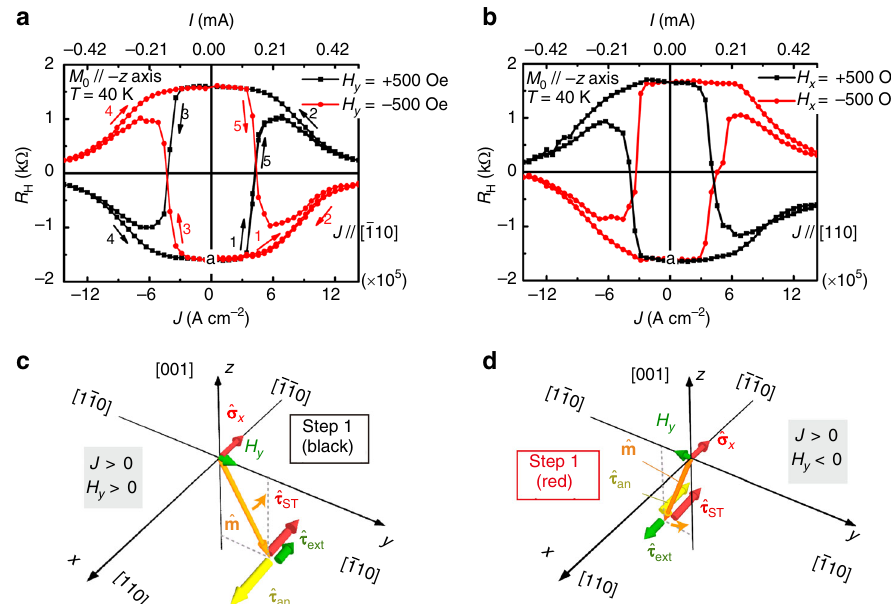
Fig. 2 SOT switching (40 K) and the relevant switching mechanism. a , b Field-assisted SOT switching with J // (cid:1) 1 10 ½ (cid:2) and H y = ± 500 Oe ( a ) and with J // [110] and H = ± 500 Oe ( b ). c , d Illustrations of the torques exerted by the external fi eld ( ^ τ x Þ with J > 0 when H y > 0 ( c ) and H y < 0 ( d ). ^ m is in the y-z plane. (Source data are provided as a Source Data fi along the – x direction ð ^ τ ST